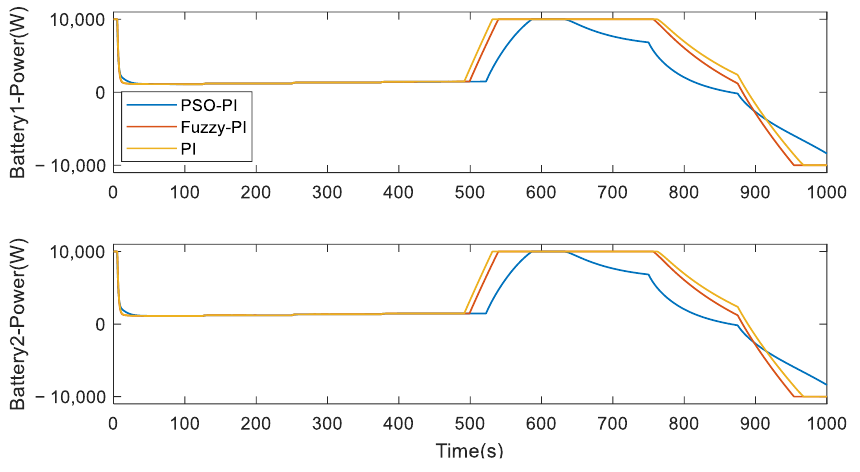
Figure 24. Output power of battery in Example 2.